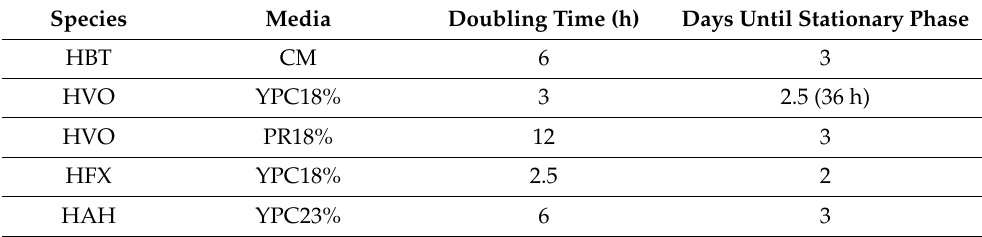
Table 3. Doubling time and incubation time for different species in different media.